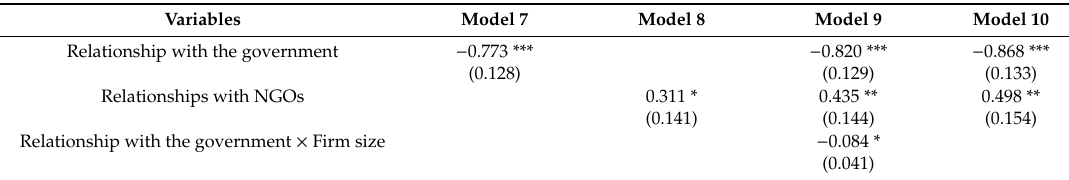
Table 4. Robustness check with alternative measure of eco-e ffi